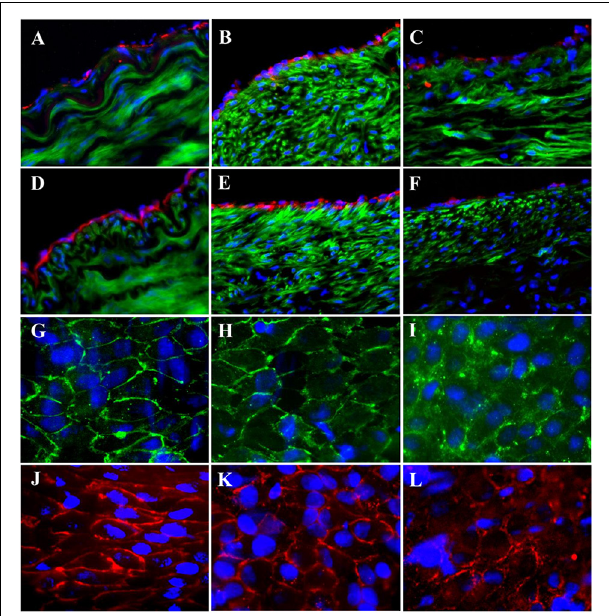
FIGURE 5 | Expression of endothelial biomarkers in neo-endothelial cells of carotid patch-angioplasty in HF/4-M Group. (A–F) Transverse. (A) Factor VIII in native artery. (B) Factor VIII in bPVP patch. (C) Factor VIII in bPcdm patch. (D) eNOS in native artery. (E) eNOS in bPVP patch. (F) eNOS in bPcdm